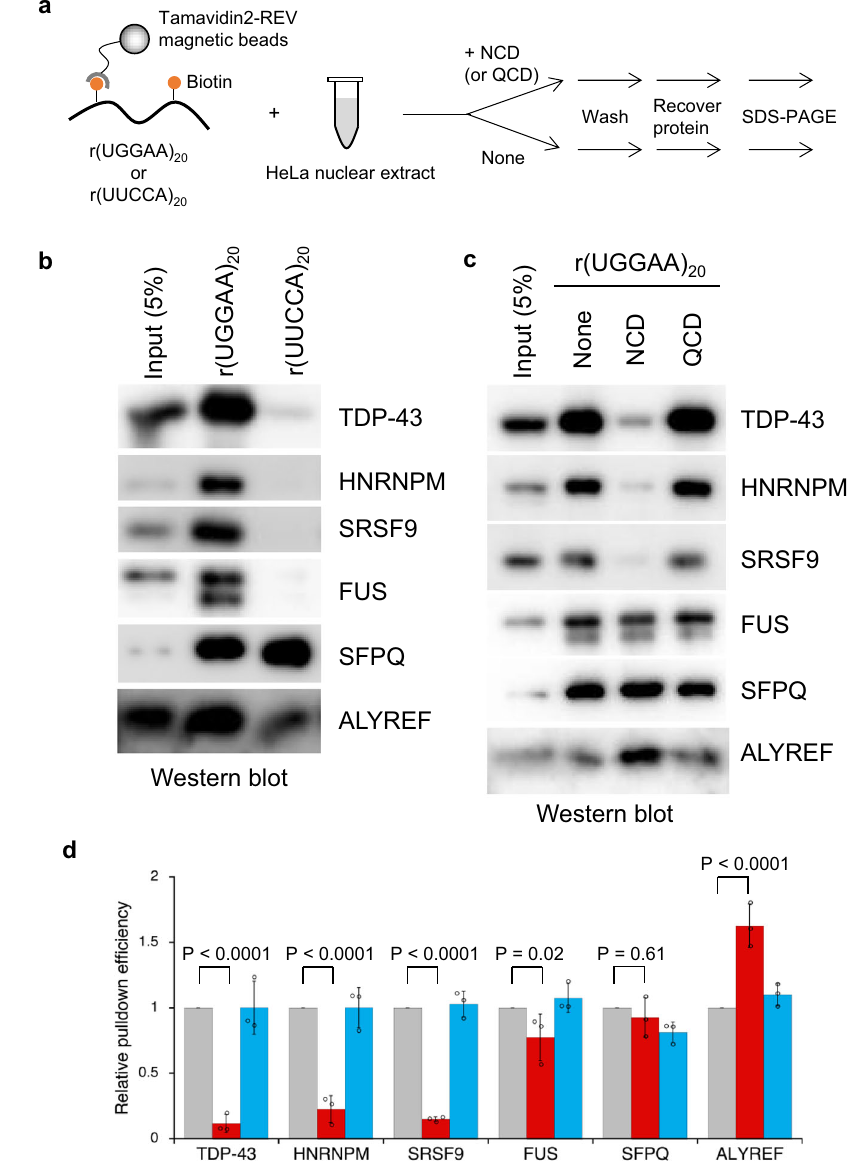
Fig. 4 Inhibition of interaction between r(UGGAA) n and RBPs by NCD. a Work fl ow of in vitro pulldown assay. b In vitro pulldown assay of RBPs using biotinylated r(UGGAA) 20 or antisense r(UUCCA) 20 . The co-precipitated proteins were detected by western blotting using speci fi c antibodies. c In vitro pulldown assay using biotinylated r(UGGAA) 20 in the absence and presence of 2 μ M NCD and QCD. d Relative pulldown ef fi ciencies of each protein in the absence (gray) and presence of NCD (red) and QCD (blue). Data are shown as the mean ± SD ( n = 3 independent experiments); (Dunnett ’ s multiple comparison test, two-sided). Source data are provided as a Source Data fi